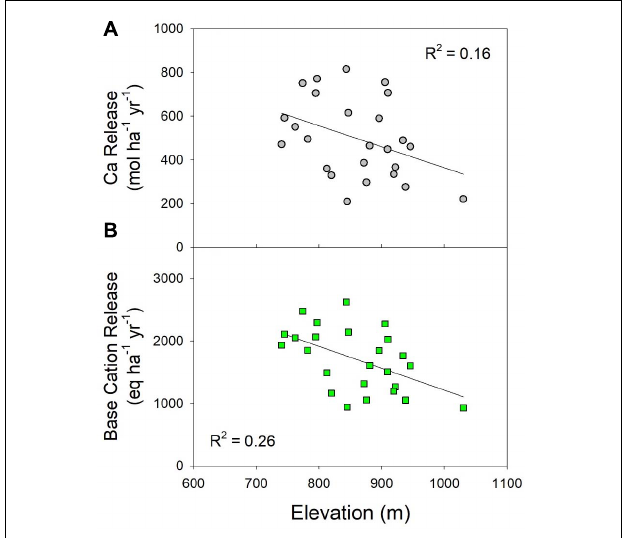
FIGURE 6 | Correlations between watershed average elevation and (A) the net geochemical release rate of Ca ( P = 0.055); (B) the total base cation net geochemical release rate ( P = 0.009). Least-squares regression lines are shown for reference